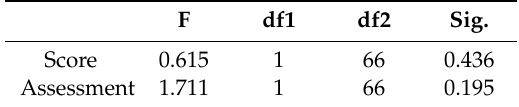
Table 5. Results of Levene’s test for equality of variances (academic year).